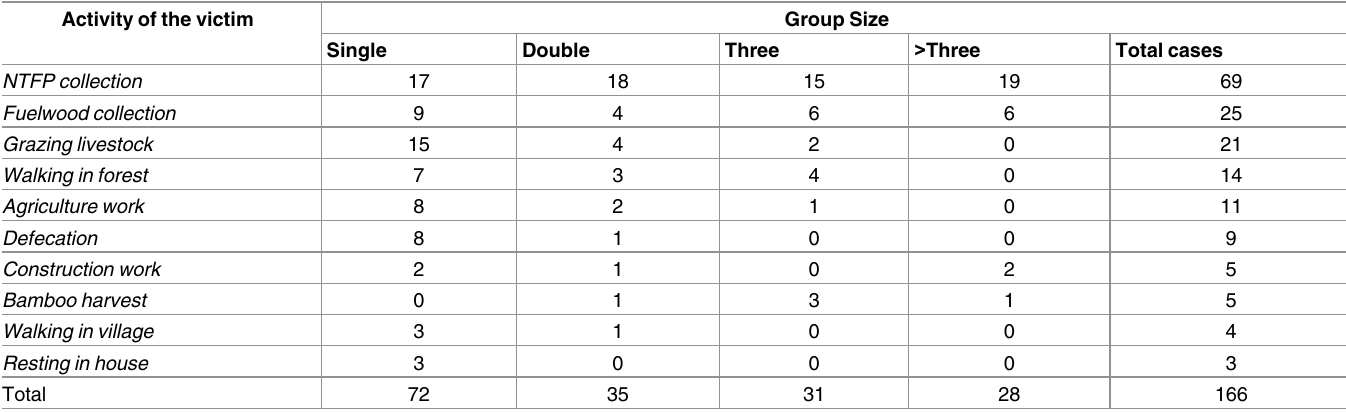
Table 2. Activity and group sizes of